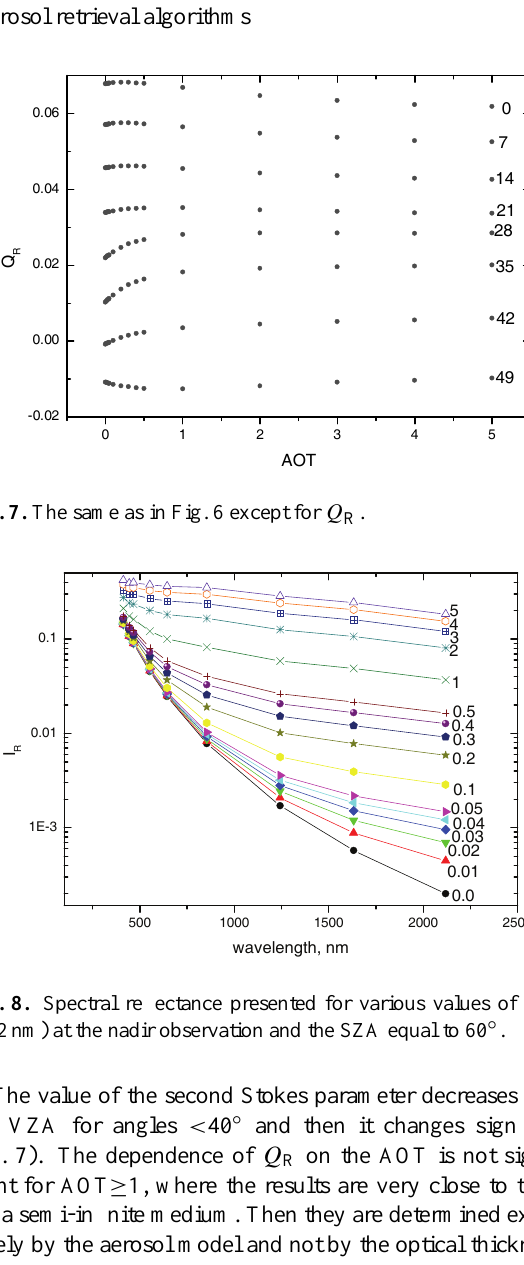
Fig. 6. The same as in Fig. 5 except as the function of AOT (412nm) for the VZA = 0 ◦ (7 ◦ ) 49 ◦ and the discrete points, where forward calculations were performed. The upper points corre- spond to VZA = 49 ◦ and the lower system of points corresponds to VZA = 0 ◦ .